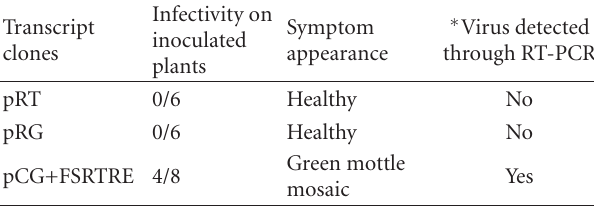
Figure 5: SDS-PAGE of purified chimeric virus coat protein (CP). Lane M: protein marker (Fermantas); 1: chimeric virus; 2: wild-type CGMMV. It is clearly shown that the chimeric virus consisted of two di ff erent CP species. The higher molecular band shows the EB4- fusion CGMMV coat protein. The ratio of modified to unmodified CP was approximately 1:1. Table 1: Summary of experiments carried out to assess the infectivity of di ff erent transcript clones. ( ∗ Total RNA was extracted from new noninoculated leaves (third new leaf) of transcript infected